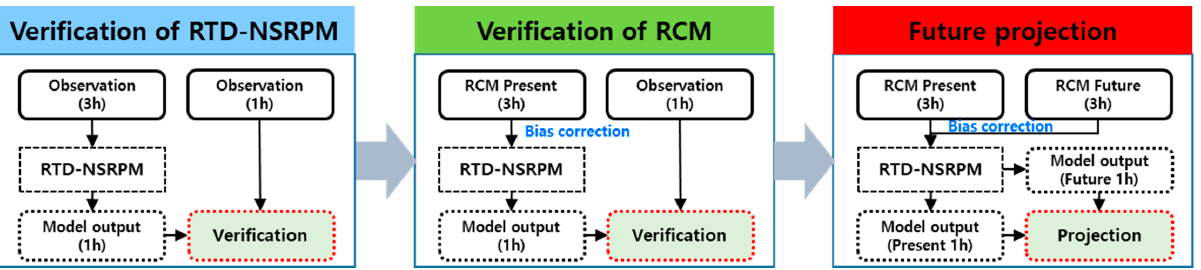
Figure 5. A schematic diagram of the evaluation strategy.